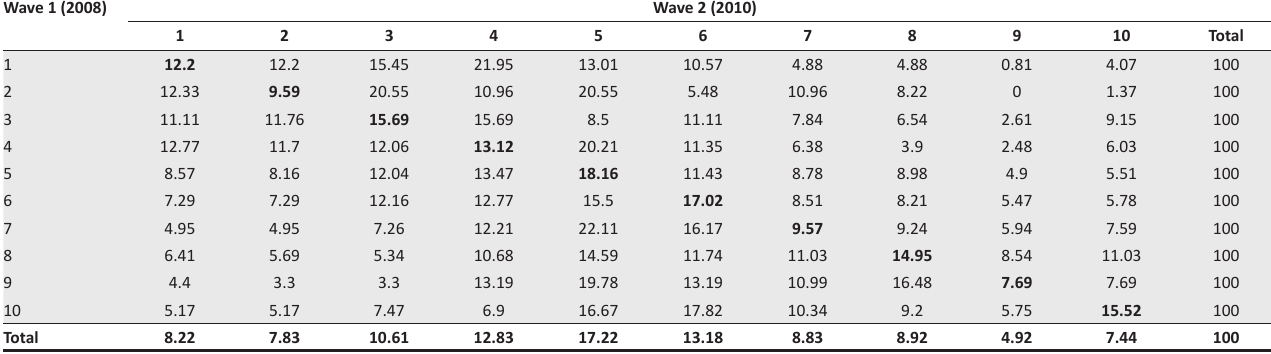
TABLE 1-A1: Subjective well-being transition dynamics, 2008–2010 (percentage). Wave 1 (2008)